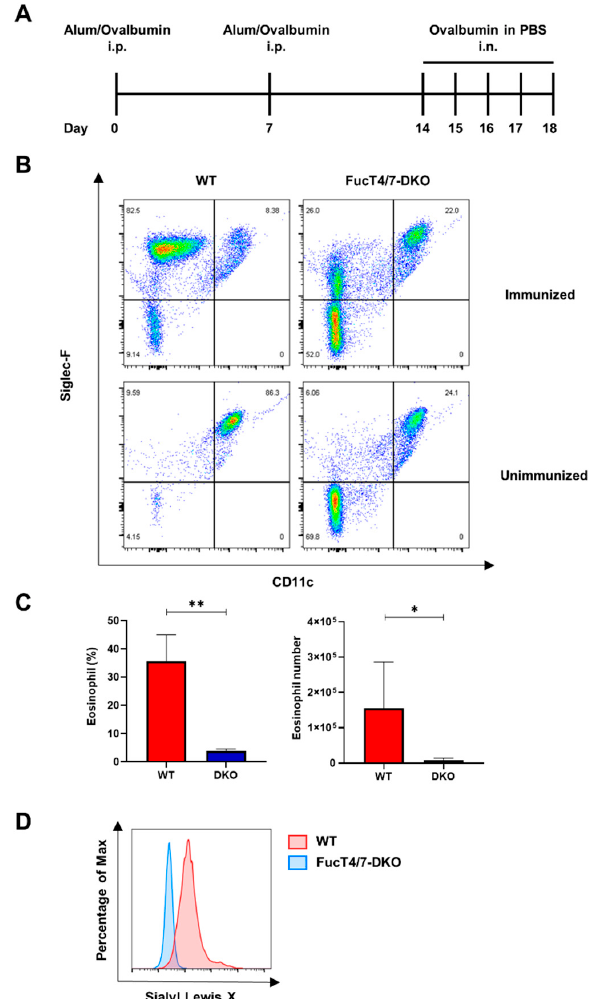
Figure 1. SLex deficiency of eosinophils resulted in diminished infiltration into the lungs. ( A ) The schedule of the immunization. Intraperitoneal injection of 100 μ g OVA emulsified with ImjectAlum was used for sensitization on days 0 and 7. The challenge was performed under isoflurane anesthesia by intranasal injection of 100 μ g OVA once a day for 5 days starting days 14. The mice were sacrificed 24 h after the final challenge. ( B ) The harvested BALF was analyzed using flow cytometry. The eosinophils were defined as CD45 + Siglec-F + CD11c − . The alveolar macrophages were defined as CD45 + Siglec-F + CD11c + . The number in the corner shows the percentage of each cell population. ( C ) The percentage of eosinophils in the whole leukocytes and the number of eosinophils were calculated. At least four mice were included in each group. The experiments were conducted twice independently. ( D ) The expression of sLe x on the eosinophils was determined using mAb F2. * p < 0.05, ** p < 0.01 A p -value of less than 0.05 was considered significant.